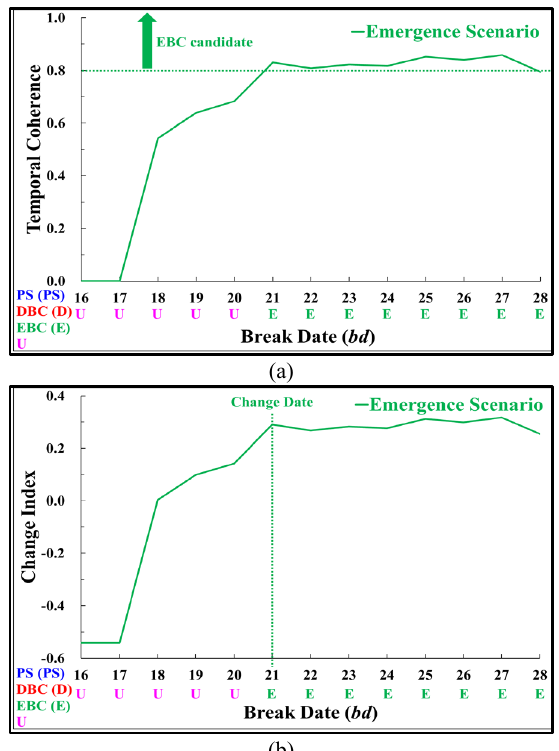
Figure A.2. Example of EBC point’s (a) temporal coherence sequence and (b) chance index sequence along with initial point